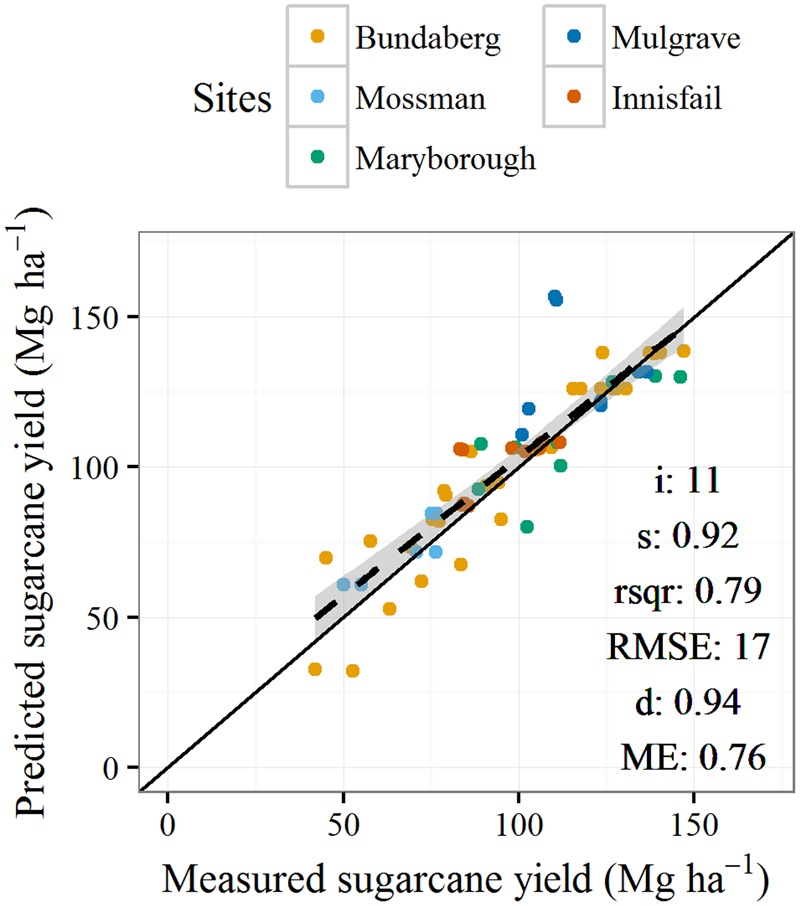
Measured (mean of replicates) and predicted sugarcane yield for five nitrogen response experiments (listed in Table 1). Nitrogen fertilizer application rates ranged between 0 and 240 kg N ha-1. Definitions of statistics presented in the figure are: i, intercept; s, slope; rsqr, r2; RSME, root mean square error; d, index of agreement (Willmott, 1982); ME, model efficiency (Nash and Sutcliffe, 1970).